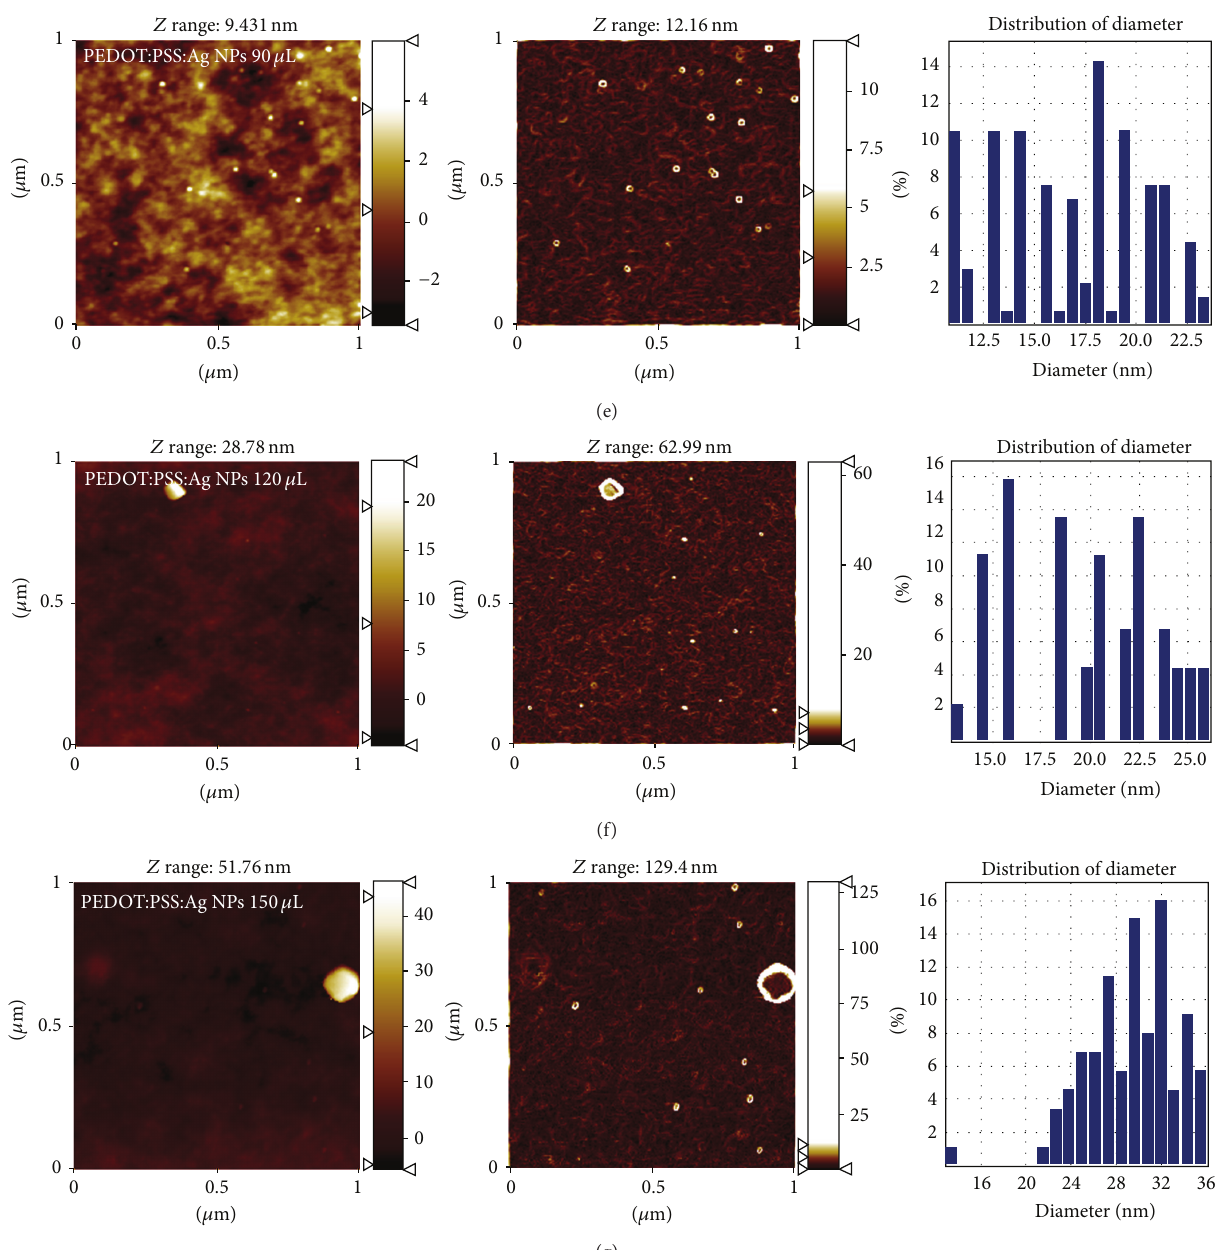
Figure 2: AFM images (topography and Sobel transform) of PEDOT:PSS, P3HT, Ag NPs, and PEDOT:PSS:Ag NPs (60, 90, 120, and 150 𝜇 L of silver NPs in 1mL of PEDOT:PSS layer) along with particle size distribution calculated by AFM analysis for scan field 3 × 3 𝜇 m, from top to bottom,